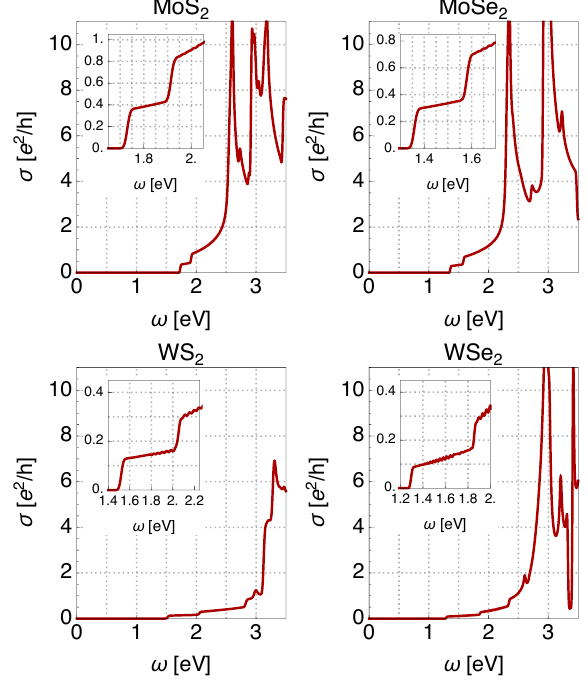
Figure 5. Optical conductivity of the four compounds, calculated from the TB model. The insets show the respective low energy zooms of σ ( ω ) around the onset of optical